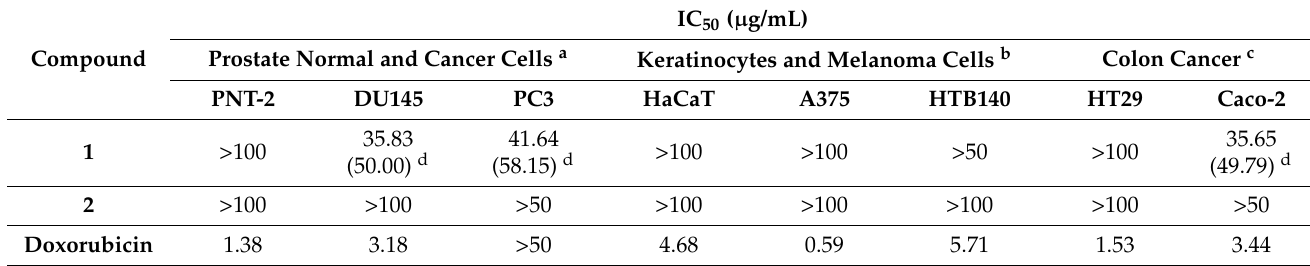
Table 3. Cytotoxicities of 1 and 2 against human normal and cancer cell lines, after the 24 h treatment (5–100 µ g/mL). IC 50 ( µ g/mL) Prostate Normal and Cancer Cells a Keratinocytes and Melanoma Cells b Colon Cancer Compound